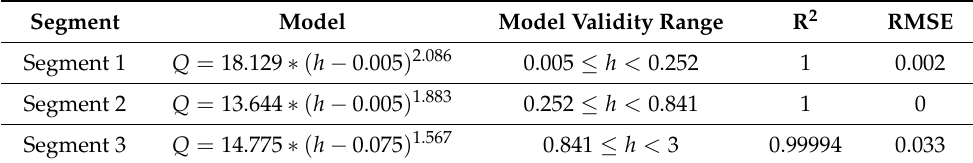
Table 3. Pontelatrave station models of the Chienti River.